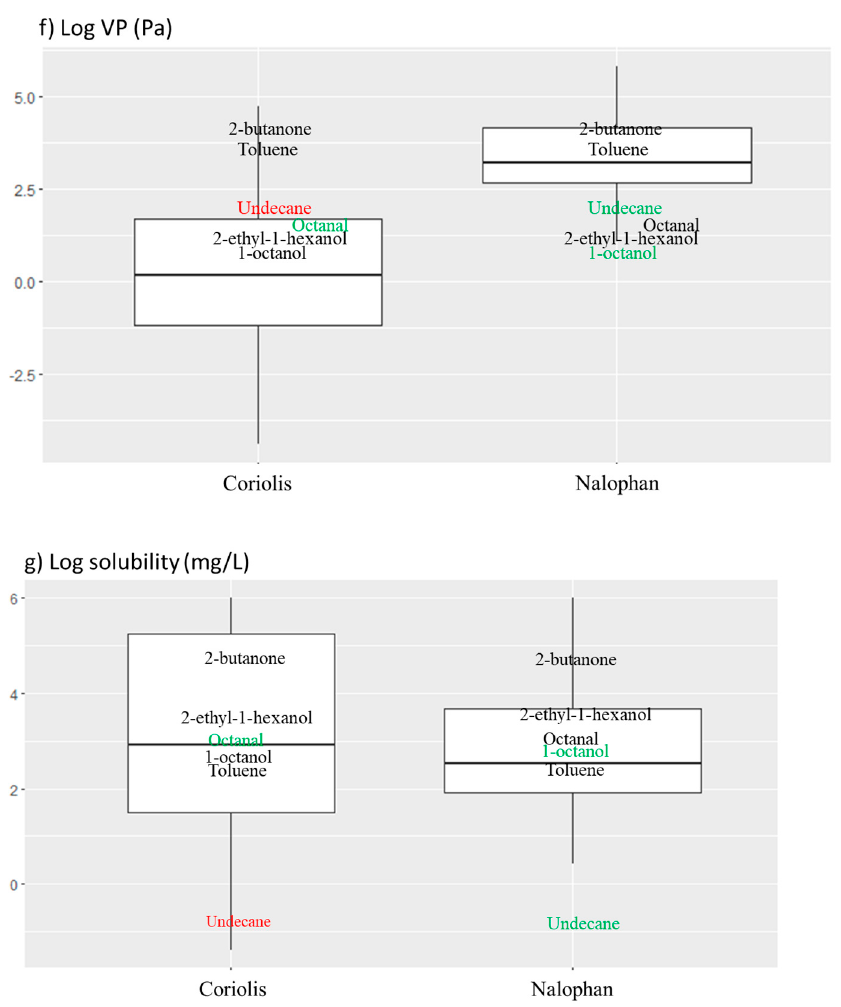
Figure 5. Box plot for each property previously presented: ( a ) log K oa , ( b ) log-transformed Henry’s constant, ( c ) log K ow , ( d ) molecular weight (MW), ( e ) boiling point (BP), ( f ) log vapor pressure (VP), and ( g ) log- transformed solubility (mg/L) with position of each molecule present in solution used to make artificial contaminated air. The molecules in green color are the molecules found only during the laboratory test, the molecules in red color are the molecules found only during the field. Black dott represents an outlier value of the boxplot.